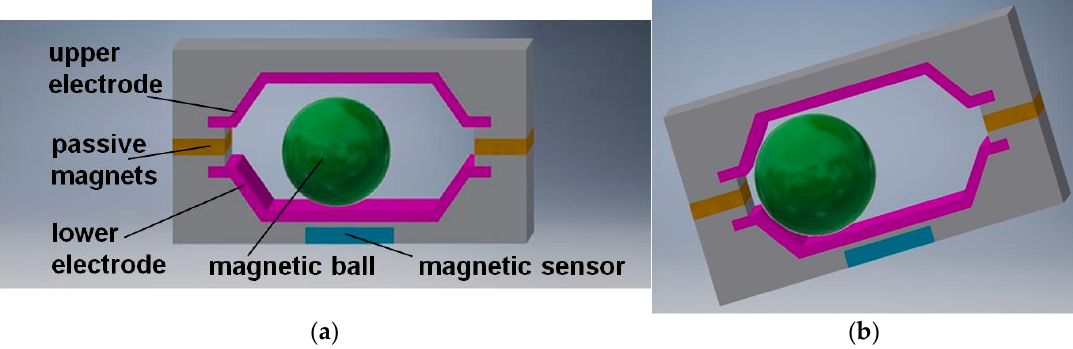
Figure 5. Tilt switch with motion detection: ( a ) the structure; ( b ) principle of operation.